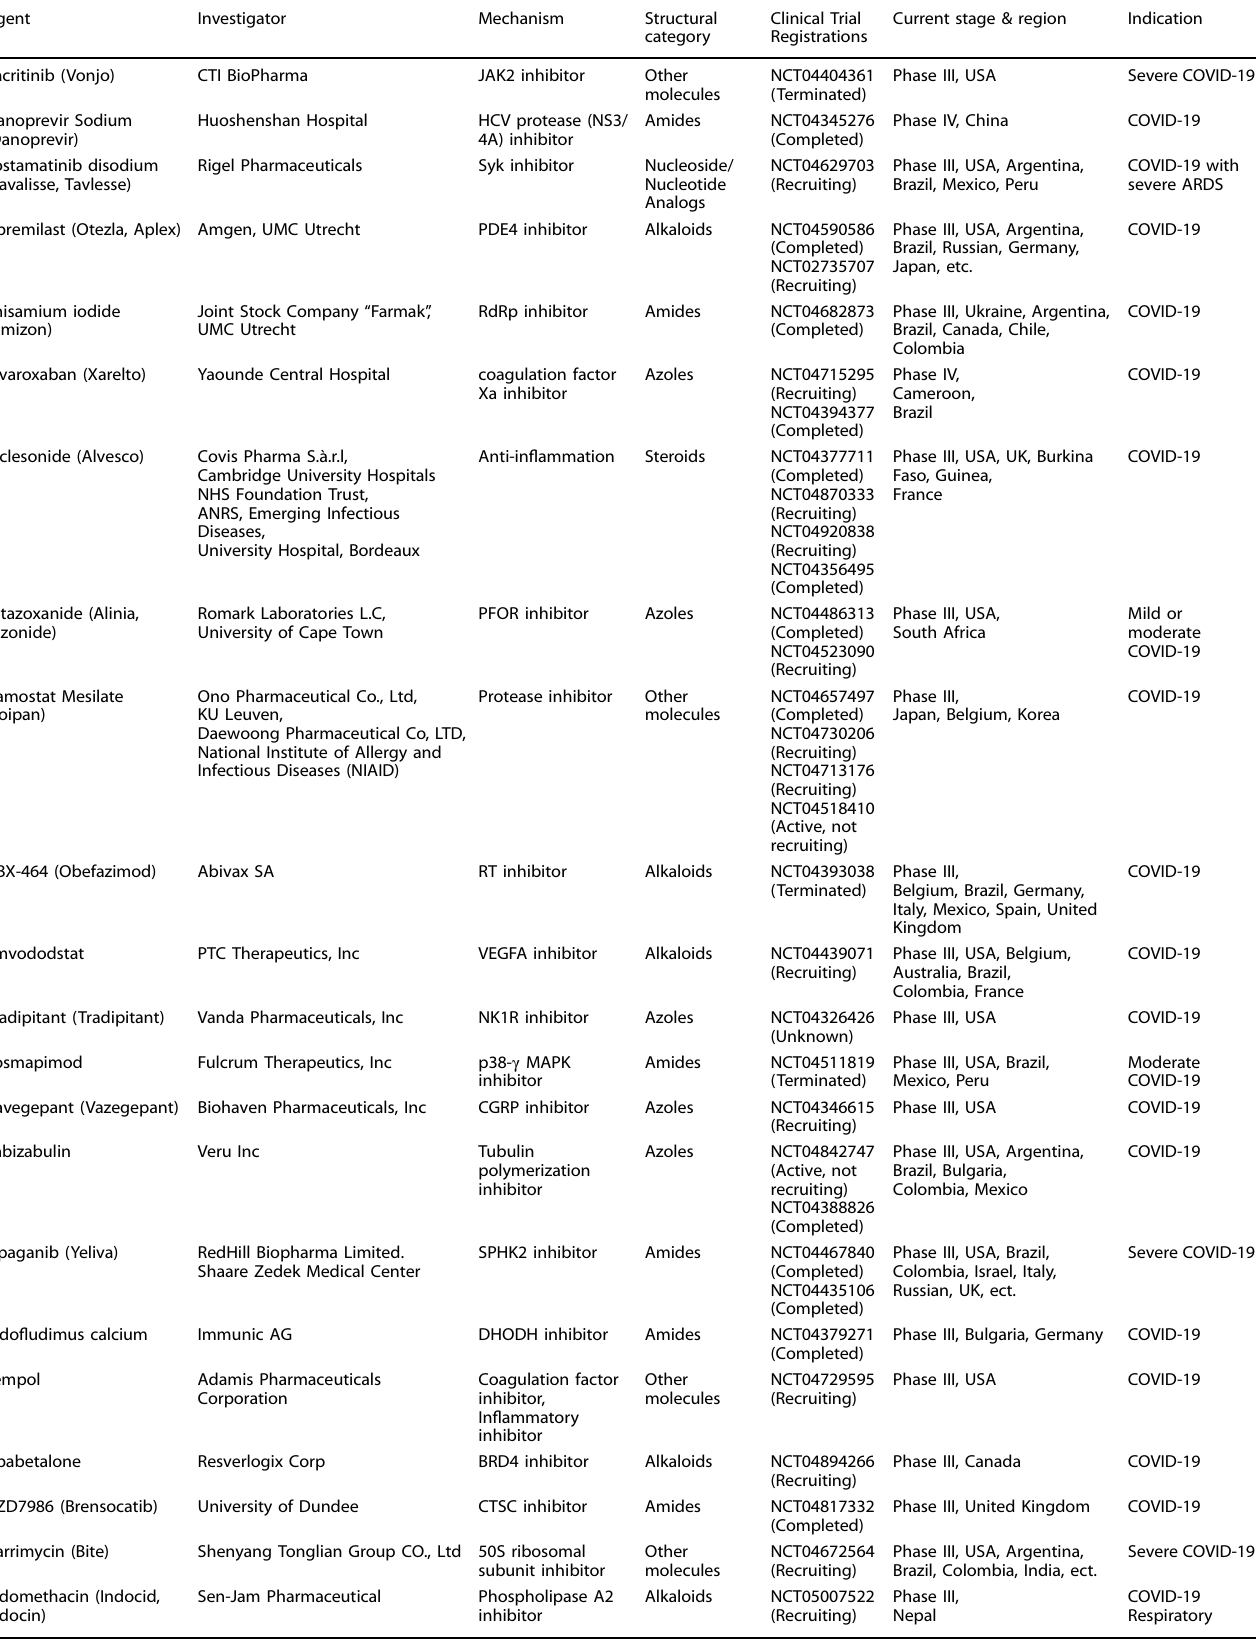
Table 2. Candidates under phase III/IV clinical trials